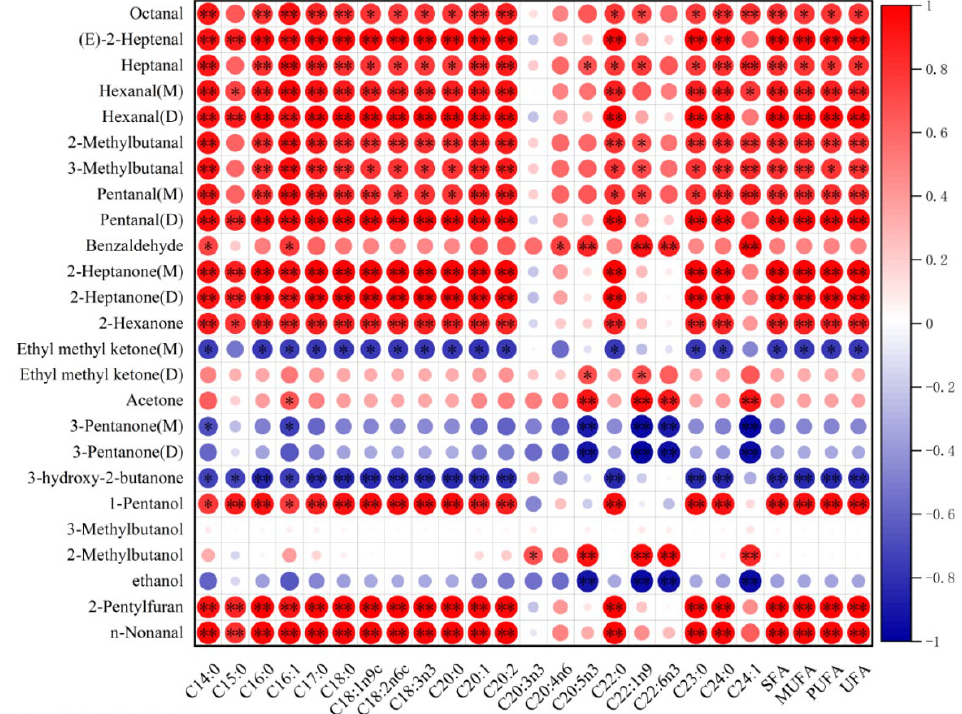
Figure 6. Correlation analysis of the free fatty acids and the volatile compounds in frying hairtail fillets. Asterisks stand for significant differences: * p < 0.05, ** p < 0.01.